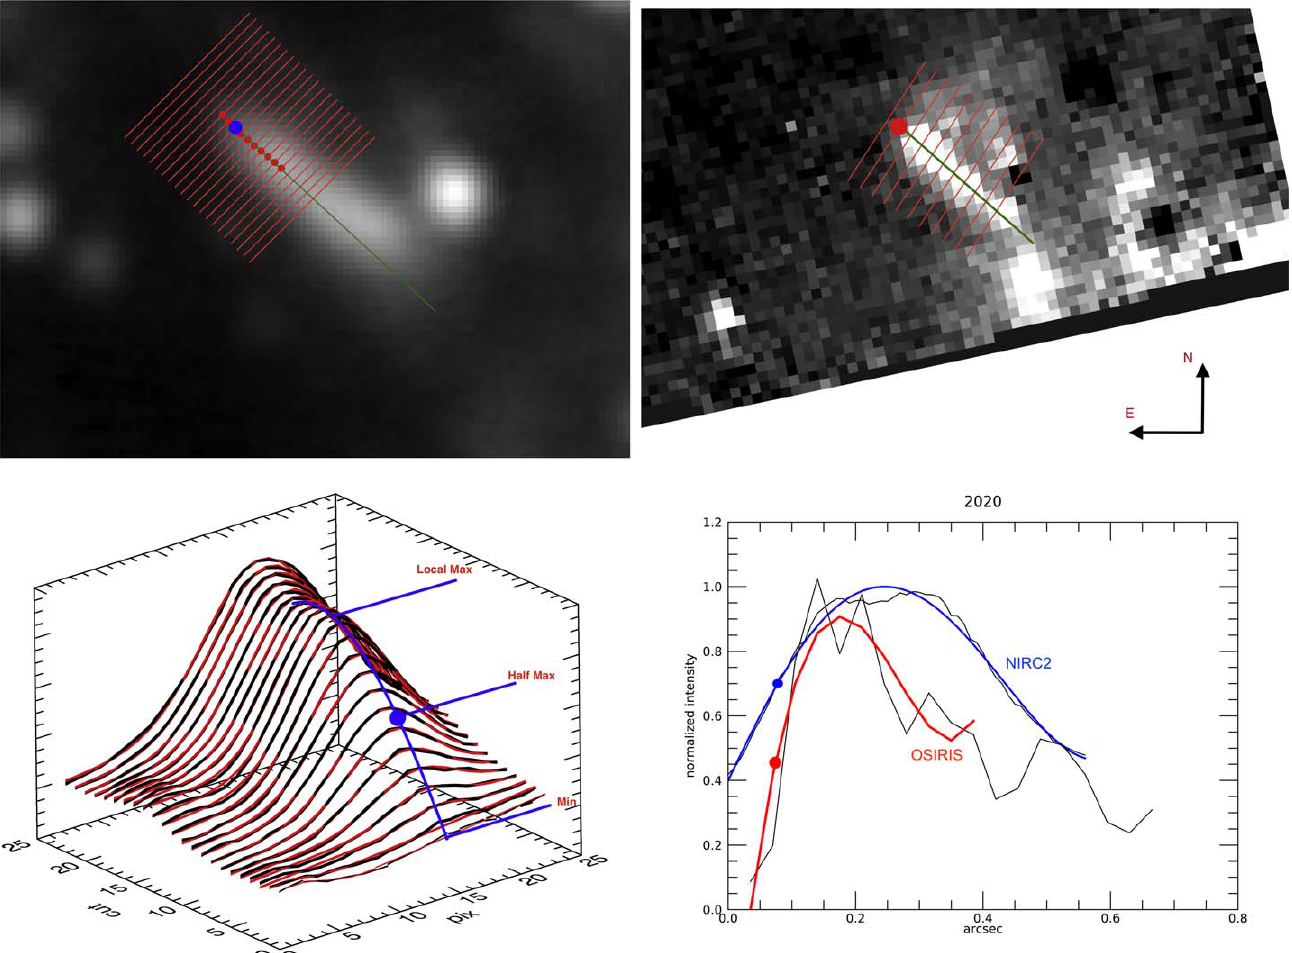
Figure 2. De fi ning the position, orientation, and pro fi le of X7. Top left: NIRC2 2020 Lp image showing a series of cuts along X7 ridge. The central peak of each cut ( shown as a red dot ) is determined with a Gaussian. A linear fi t to these peaks ( green line ) de fi nes the ridge of X7, while the half-maximum along ridge pro fi le de fi nes the location of the tip ( shown as a blue dot ) . Bottom left: 3D rendering of the NIRC2 cuts ( the vertical axis represents the intensity ) in black, together with the corresponding Gaussian fi t overplotted in red and the tip measurement in blue. Top right: OSIRIS 2020 Br- γ narrowband image of X7 that highlights the series of cuts used to measure the tip location. Bottom right: Comparison of X7 ʼ s ridge pro fi le in dust ( NIRC2- Lp ) and gas ( OSIRIS Br- γ ) emission ( extracted along the green lines shown in the top panels ) . A polynomial fi t to each of the pro fi les, along with the measured location of the tip, is shown in blue for NIRC2 and in red for OSIRIS. The pro fi les are shifted along the direction of the ridge to match the half-max